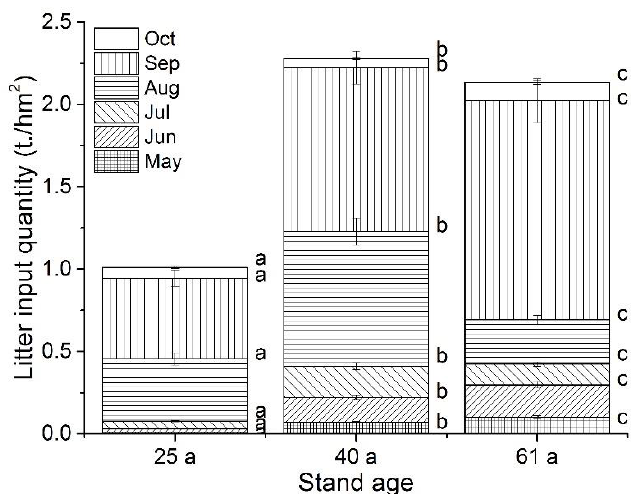
Figure 7. The litter input quantity during the study period (May to October 2018) in different- aged Betula platyphylla forests of permafrost region, Northeast China. Lowercase letters (a, b and c) represent significant differences under the same month and varied stand age ( p < 0.05). Error bars indicate the standard deviation ( n =